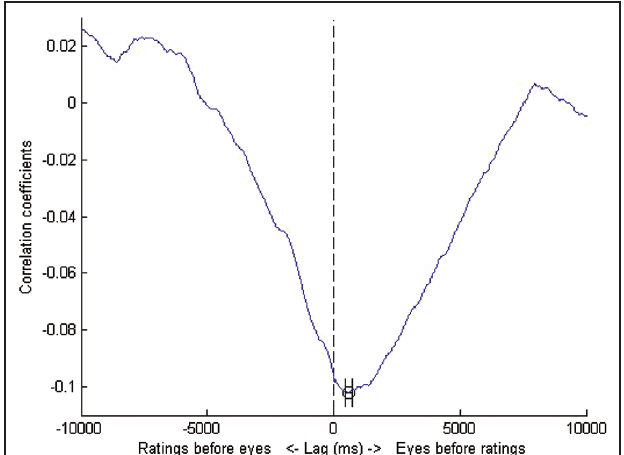
FIGURE 1 | DAF analysis for untrained observers . The maximally negative correlation was obtained at a lag of 580 ms i.e., the eyes led manual responses by a lag of just over half a second. Error bars represent standard errors obtained by bootstrapping.